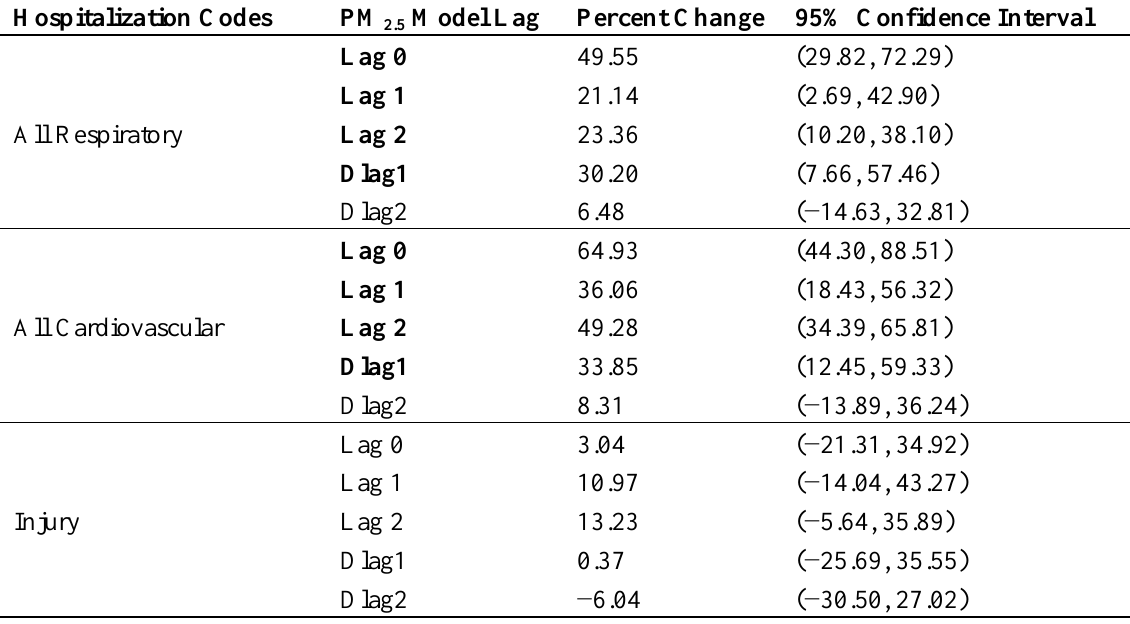
Table 3. Percent change in hospital admissions for the haze period compared to the non-haze period in the affected region controlling for PM Bolded model lag types denote significant change in hospital admissions at the 0.05